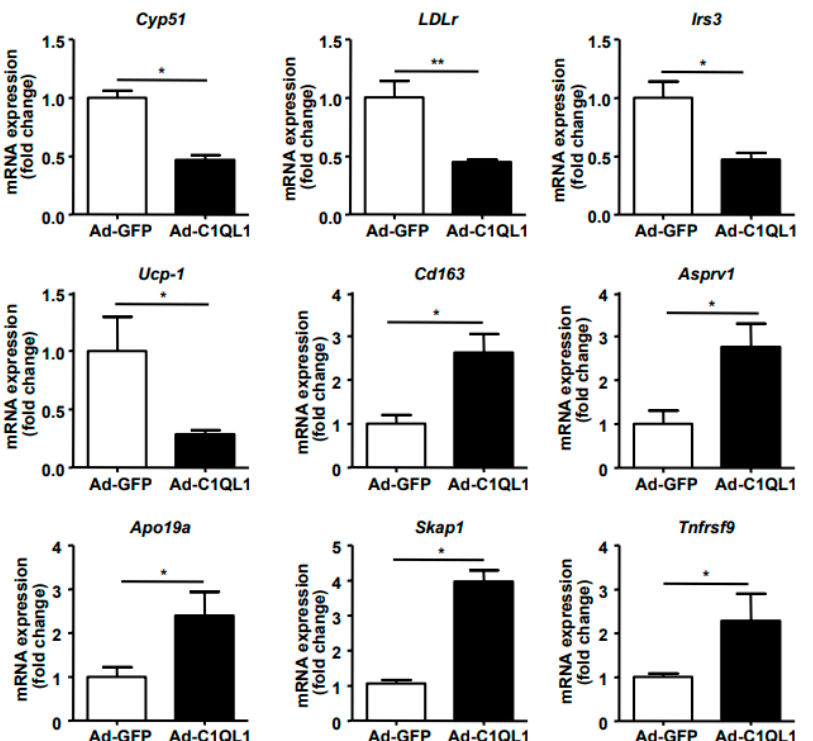
Figure 9. Real-time PCR was performed to identify gene expression in the RNA seq analysis. Genes were randomly selected from all 111 DEGs. n = 3 for each cohort. Data are presented as the mean ± SEM. * p < 0.05, ** p < 0.01, Ad-C1QL1 versus Ad-GFP.